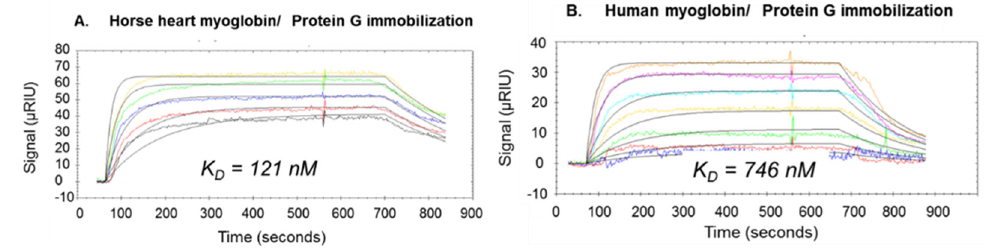
Figure 2. SPR interaction kinetics of horse heart myoglobin ( A ) and human myoglobin ( B ) with polyclonal anti-MG antibody immobilized on protein G [38].